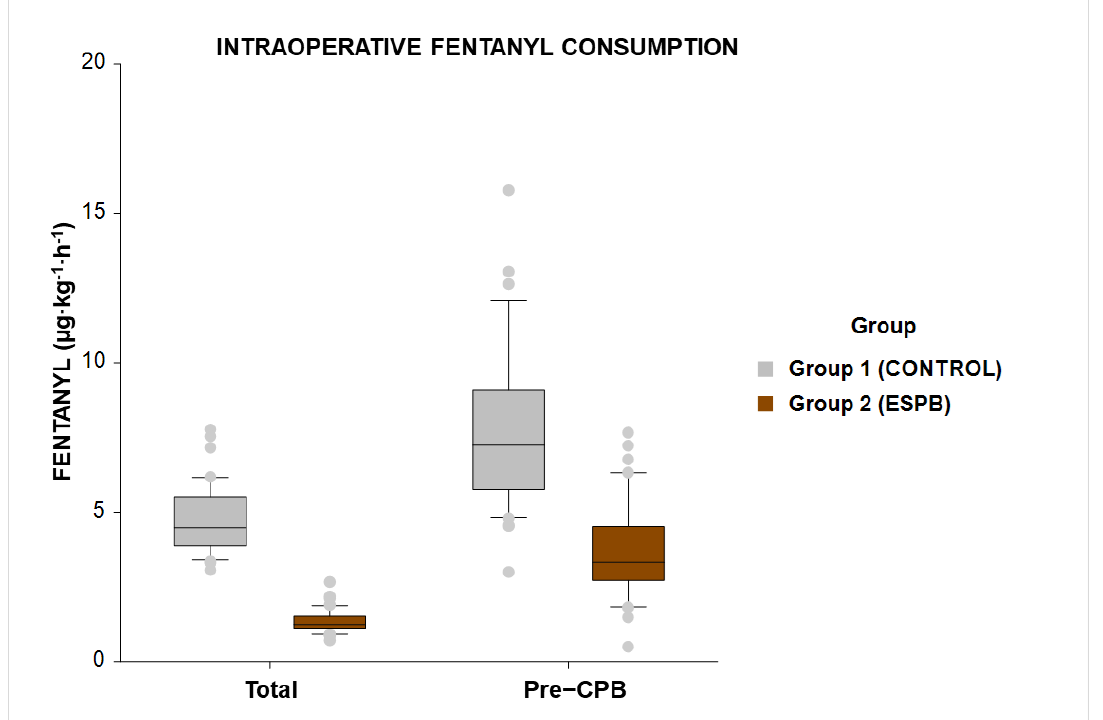
Figure 3. Intergroup comparison for intraoperative fentanyl consumption (µg·kg −1 ·h −1 ). Left, total intraoperative fentanyl consumption ( p < 0.001). Right, intraoperative fentanyl consumption before cardiopulmonary bypass initiation (pre-CPB) ( p < 0.001). For the boxplot graph, the horizontal bar indicates the median, the upper and lower box edges indicate the 75th and 25th percentiles, and the upper and lower whisker boundaries indicate the 90th and 10th percentile. Outliers are indicated above and below the whisker boundaries. Abbreviations: ESPB, erector spinae plane block.